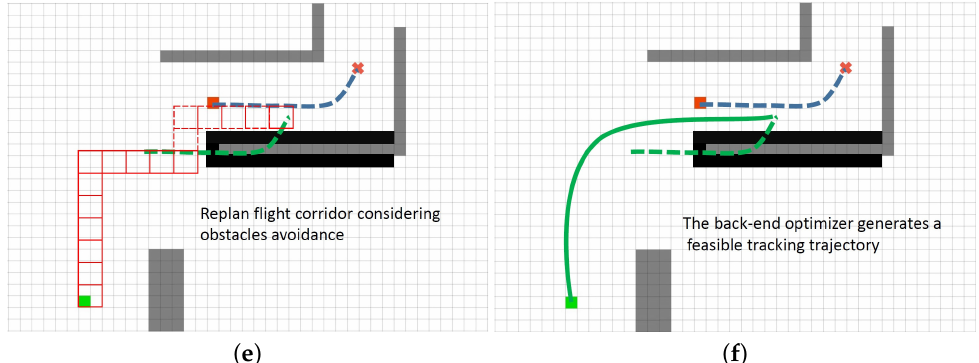
Figure 2. Graphical illustration of the algorithmic pipeline. ( a ) Observe the target trajectory by the onboard sensor. ( b ) Predict the target trajectory considering nearby obstacles. ( c ) Offset along the d s vector to generate rigid target tracking trajectories. ( d ) Connect to the drone and generate initial flight corridor. ( e ) Generate the re-planned flight corridor considering obstacles avoidance. ( f ) The back-end optimizer generates a feasible tracking